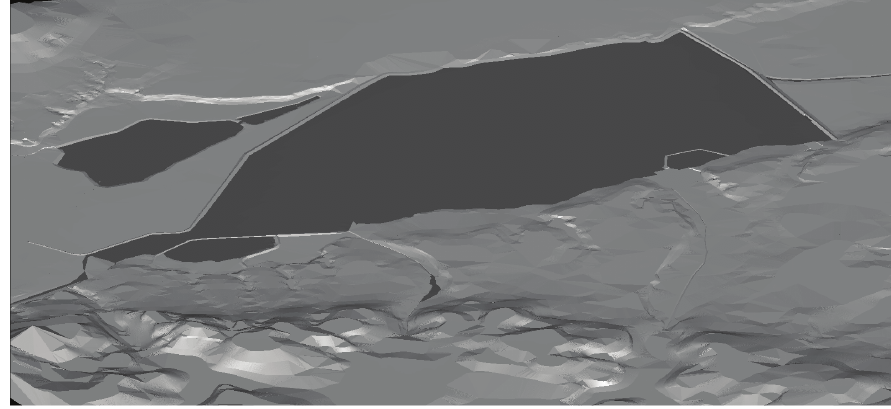
Fig. 14. Mutual penetration of numerical terrain model and numerical unconfined water table